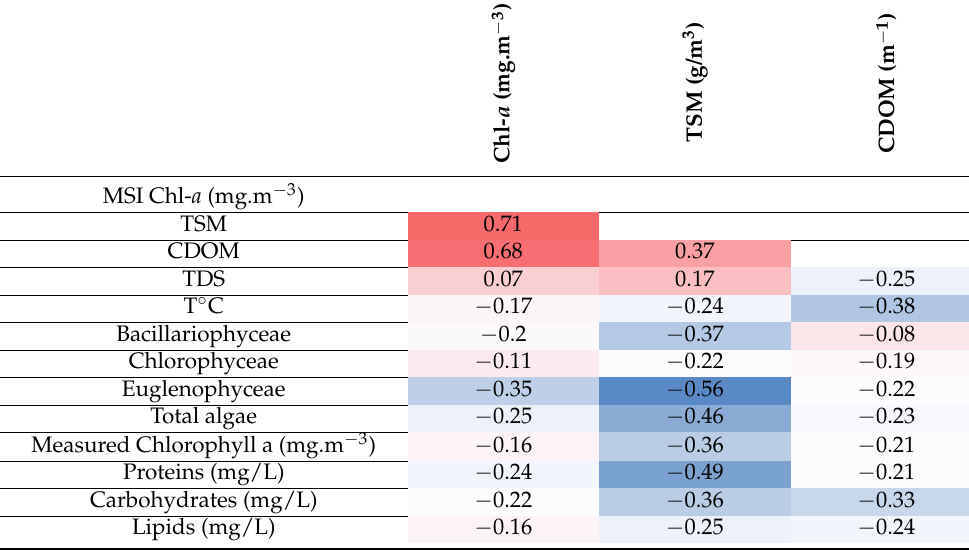
Table 10. Pearson’s correlation coefficients of in situ measured and S2 MSI-derived water quality parameters in Burullus